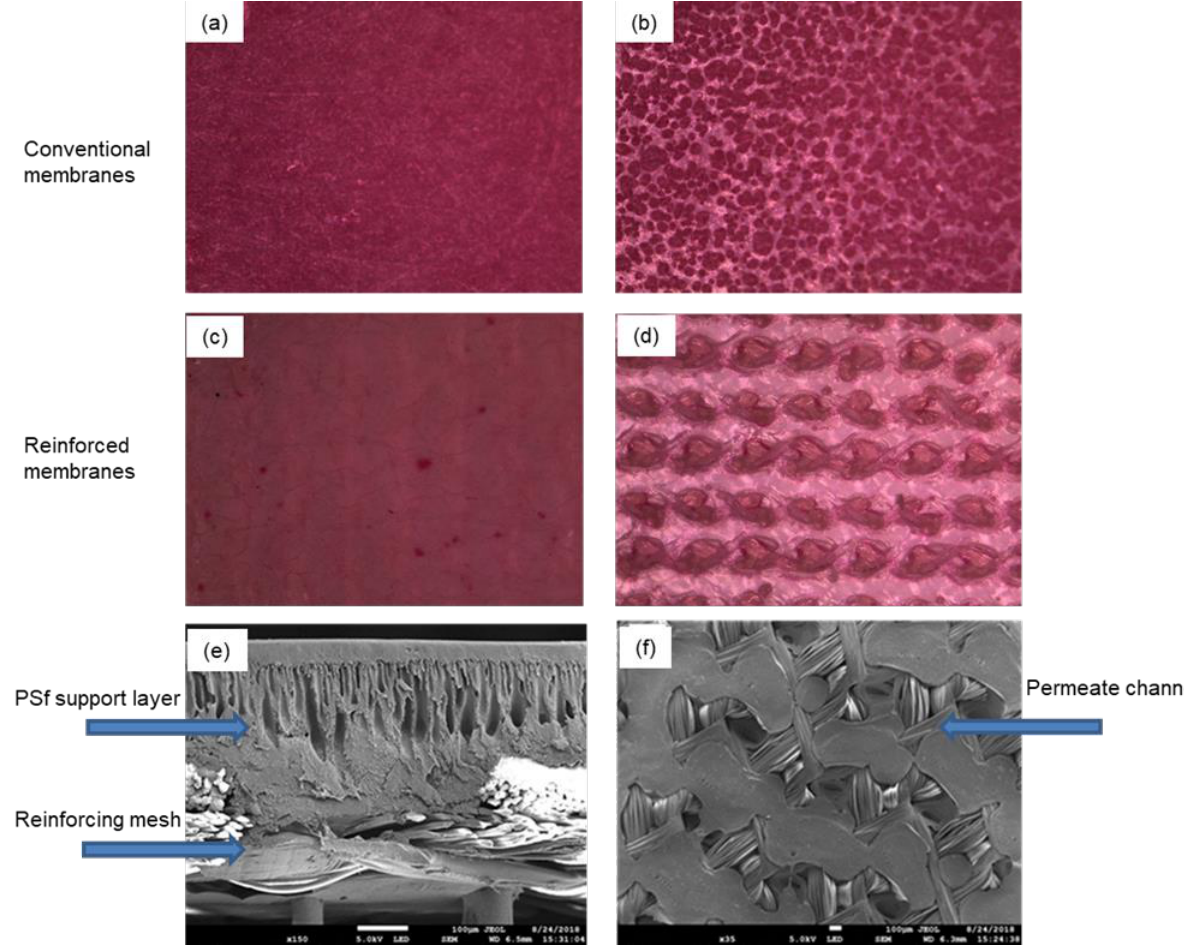
Figure 6. Optical microscope images of the front (selective layer) and back (support layer) surfaces of the reinforced membrane coated with polyamide thin-film composite coating on a conventional non-woven polyester backing ( a , b ) and on a TJ-30 permeate carrier ( c , d ). ( e , f ) FESEM images of the cross-section and the back side of the reinforced membrane, respectively.